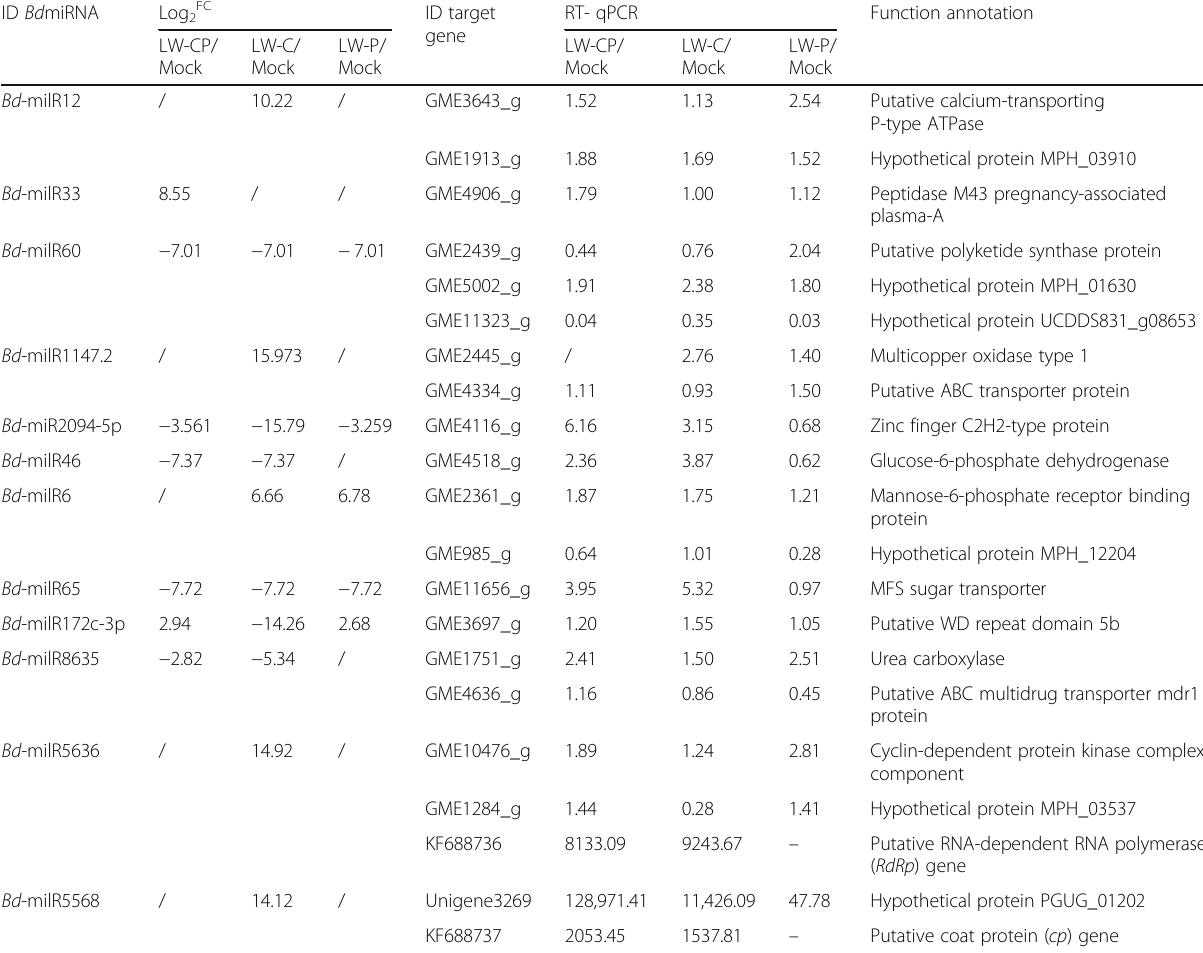
Table 4 The patterns of differentially expressed Bd -milRNAs and targeted gene mRNAs analyzed in mycelia from Botryosphaeria dothidea strains cultured for 5 d following infection with BdCV1 and BdPV1 obtained by sRNA sequencing and RT-qPCR analysis, respectively ID Bd